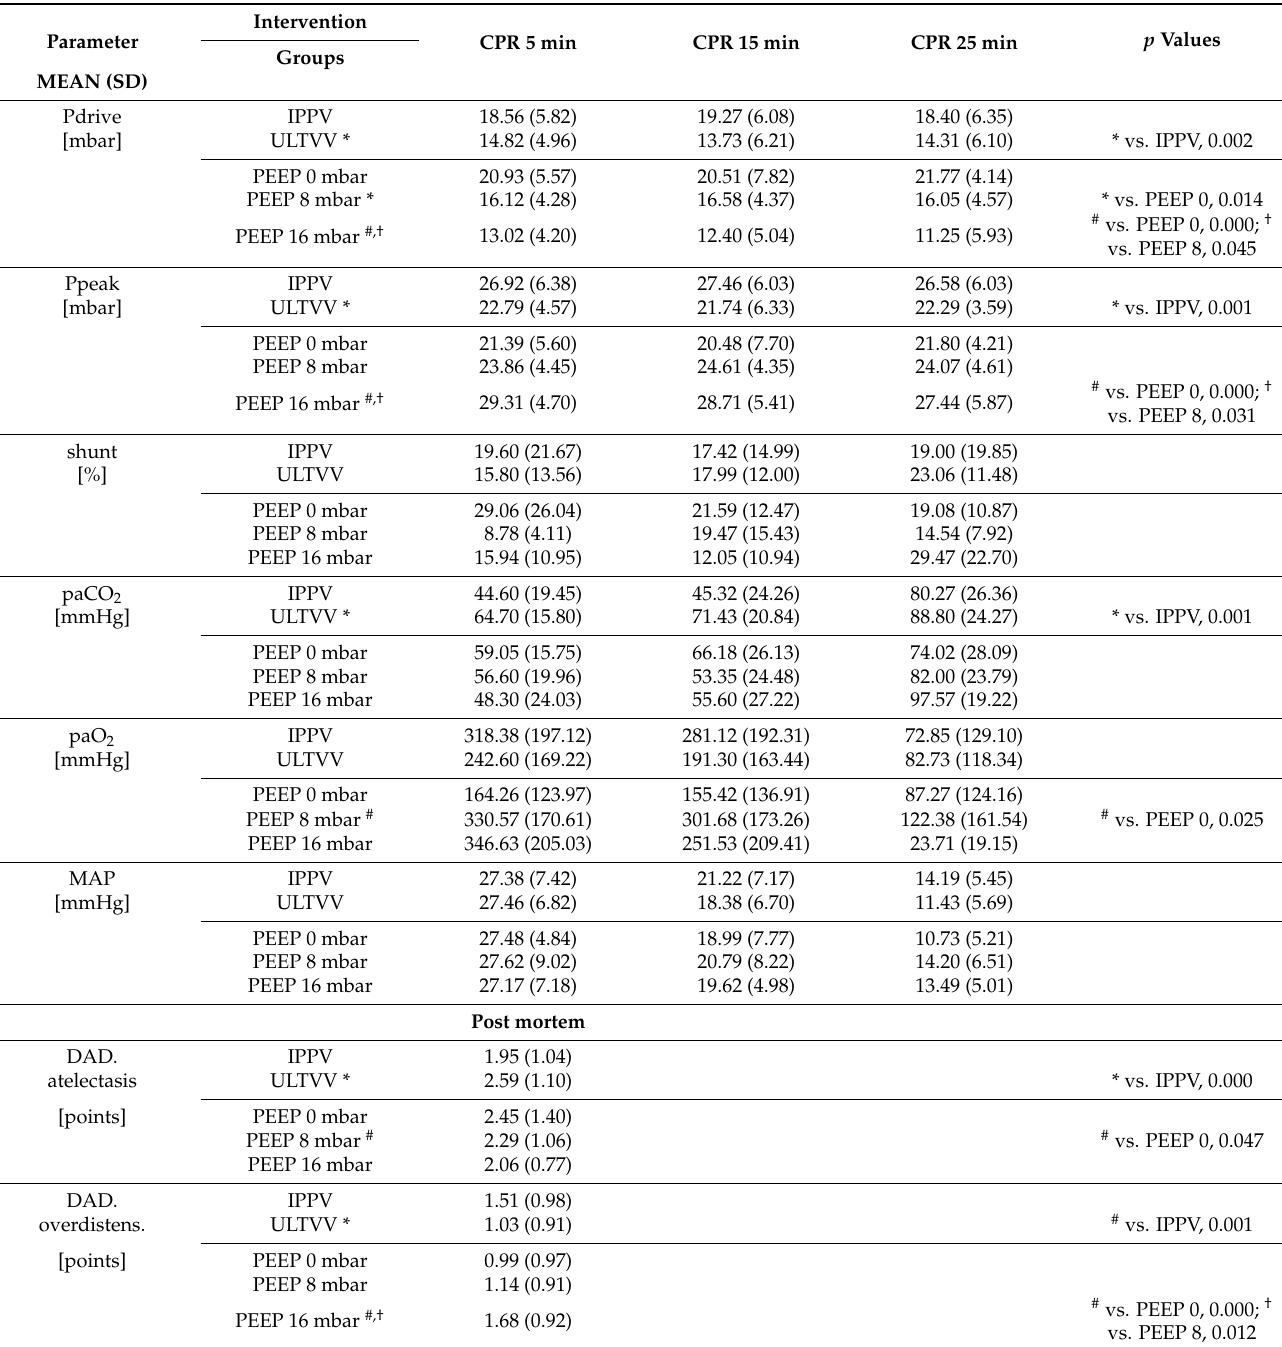
Table 2. Overview of relevant ventilation parameters, invasively measured haemodynamic param- eters, blood gases, MIGET measurement, DAD score. Standard deviation (SD), driving pressure (P drive ), peak pressure (P peak ), partial arterial pressure of carbon dioxide (paCO 2 ), partial arterial pressure of oxygen (paO 2 ), mean arterial pressure (MAP), diffuse alveolar damage (DAD) score, overdistension (overdis.), intermittent positive pressure ventilation (IPPV), ultralow tidal volume ven- tilation (ULTVV). Statistical analyses were performed using SPSS and p -values < 0.05 were considered significant. Significant statistical differences are shown with the following symbols: *, #,